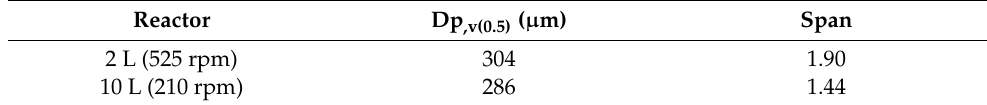
Table 4. Median particle sizes in volume and span.